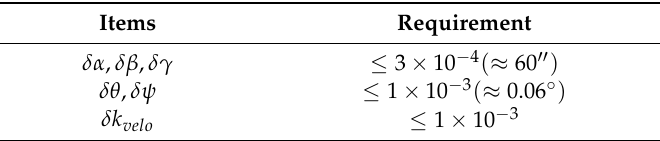
Table 1. Accuracy requirements for Equation (6). Items